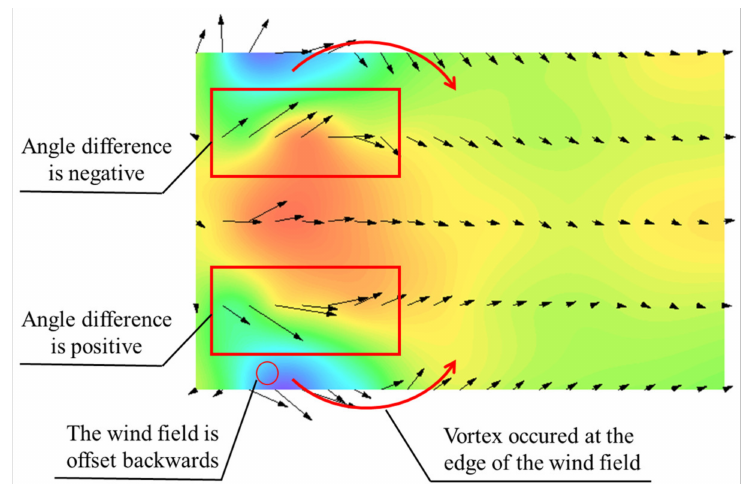
Figure 9. Offsets and vortices in the dynamic wind field.